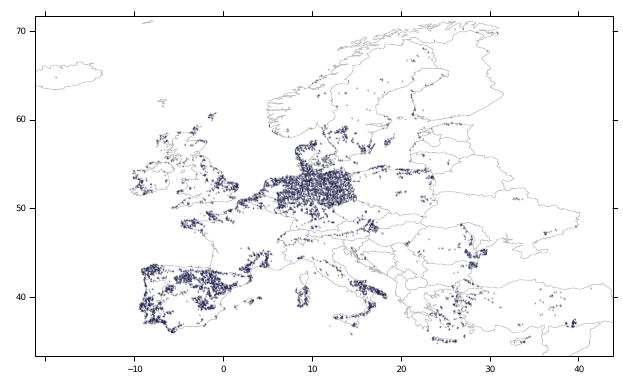
q Figure 2. Modelled spatial distribution of rated wind power capac-